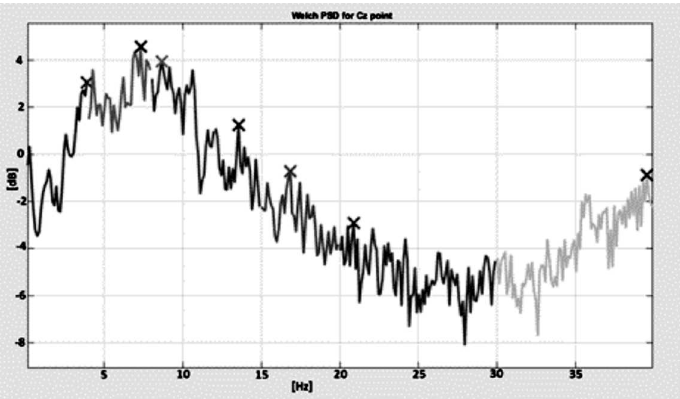
Figure 7. PSD – low frequencies, attention disorders, sample 1